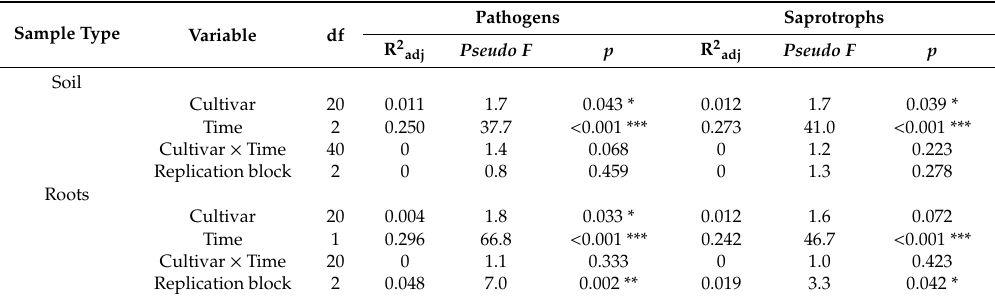
Table 2. E ff ects of cultivar, sampling time, and cultivar × sampling time interaction on the relative abundance of plant pathogenic fungi and saprotrophic fungi in soil and